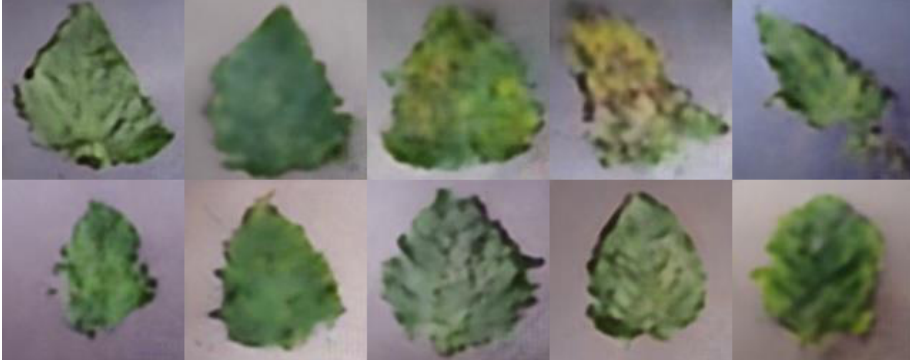
Figure 12. Examples of tomato diseased leaf generated by VAE networks: healthy, TBS, TEB, TLB,